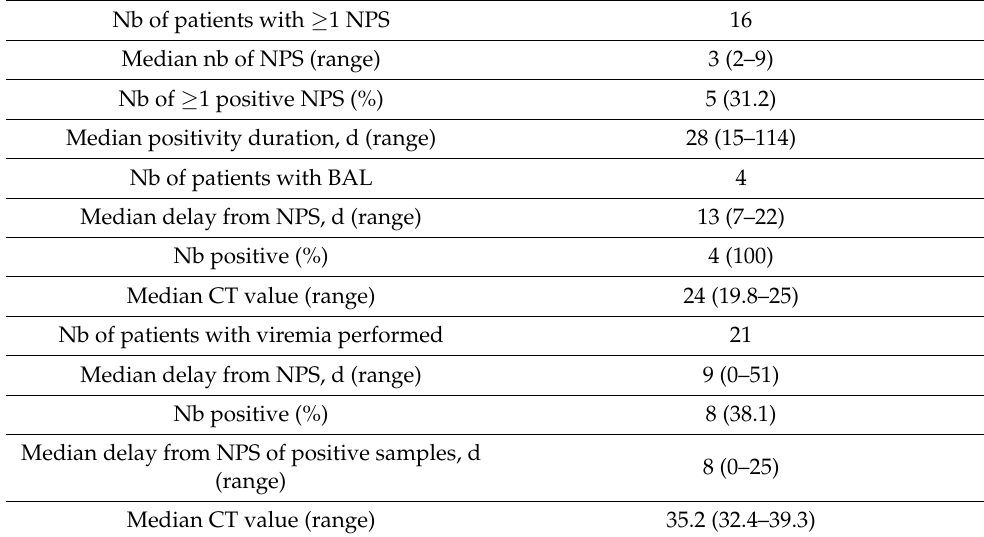
Table 1. SARS-CoV-2 RT-PCR assays of